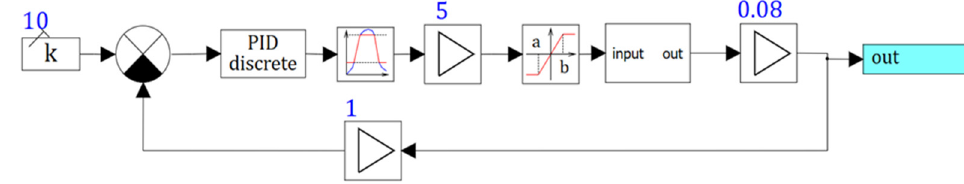
Figure 9. Schematic window with continuous-discrete actuator model in sub-model blocks.